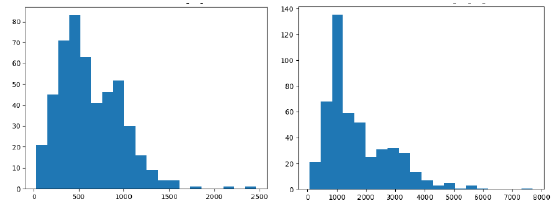
Figure 12: Histograms of the two most time consuming steps (in seconds): prepare (left), compute_dsm